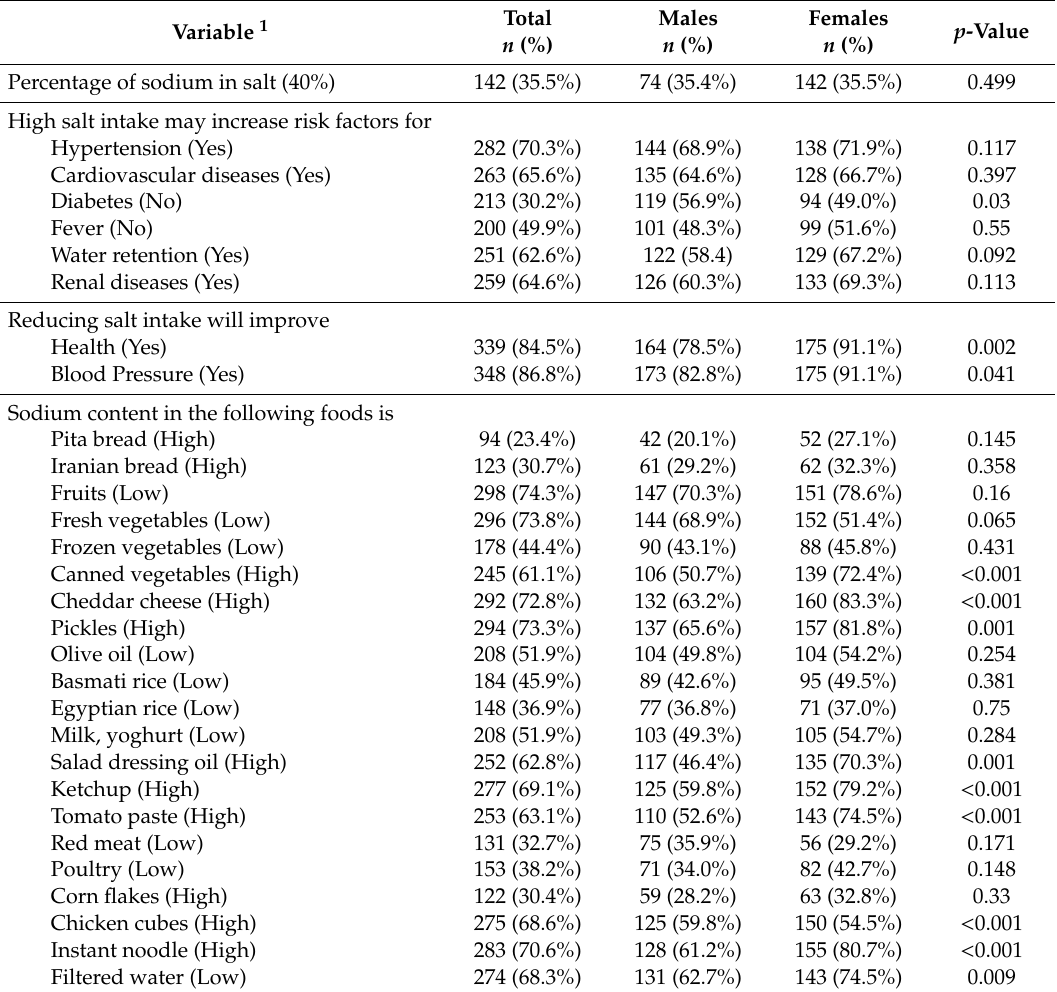
Table 2. The number and percentage of participants who answered knowledge related questions correctly among University of Sharjah (UOS) students ( n = 401) by